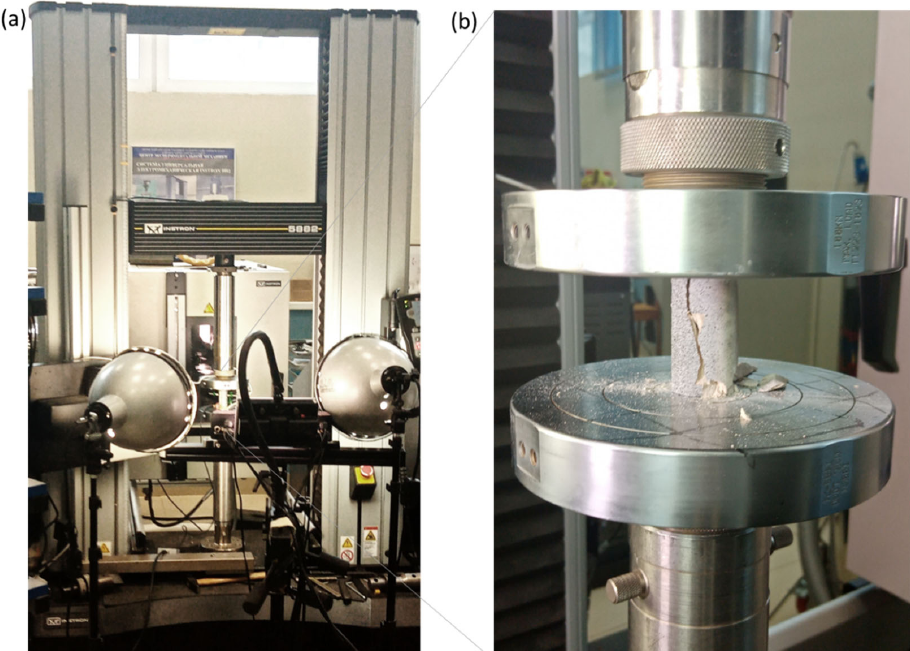
Figure 5. Photographs depicting the uniaxial compression test of the geomaterial: ( a ) Instron 5882 universal electromechanical system with the installed Vic 3D strain field registration system; ( b ) the tested sample of geomaterial between the loading plates at the final stage of loading ‐ brittle fracture in the shear mode along a single plane.